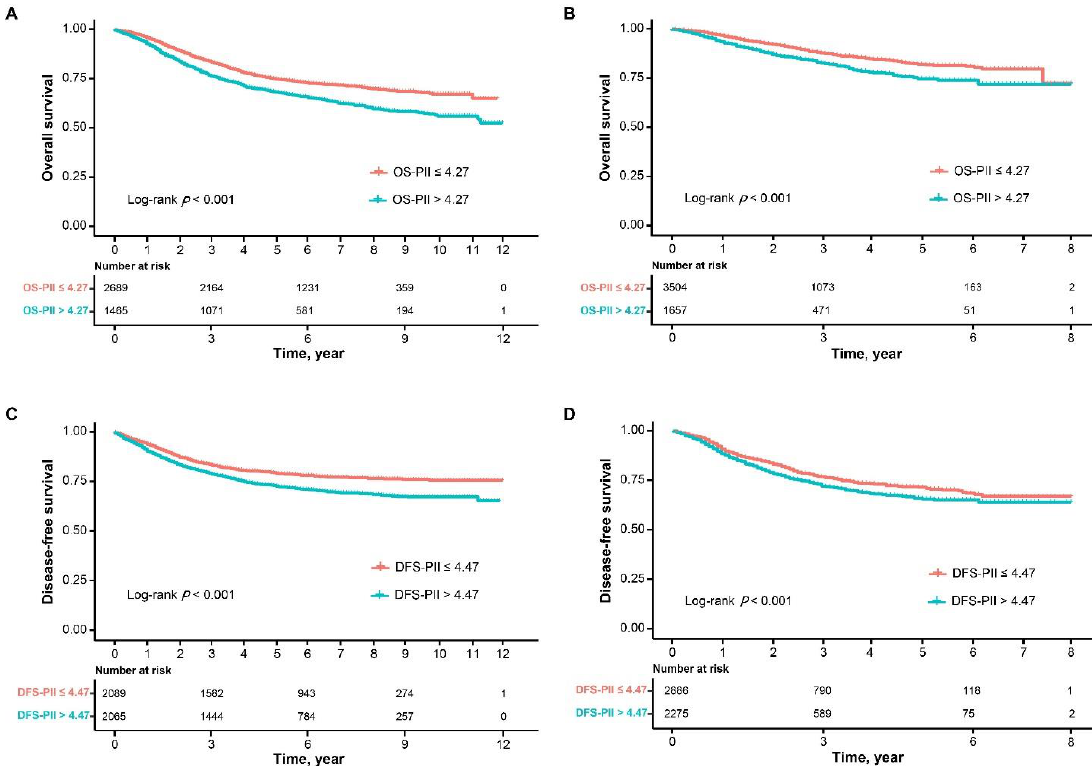
Figure 1. Kaplan–Meier curves of overall survival and disease-free survival for OS-PII and DFS-PII in patients with CRC. Kaplan–Meier curves of overall survival for OS-PII in the training cohort ( A ), and for OS-PII in the validation cohort ( B ), and Kaplan–Meier curves of disease-free survival for DFS-PII in the training cohort ( C ), and for DFS-PII in the validation cohort ( D ).